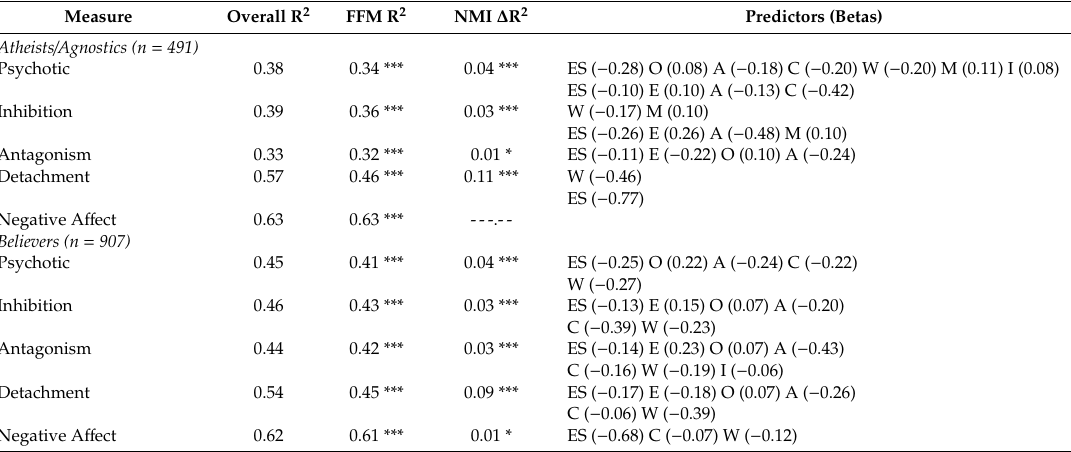
Table 5. Incremental Validity of the NMI Scales over the FFM Domains in Predicting Characterological Dysfunction on the PID-5 for Atheist / Agnostics and Other Faith Traditions.